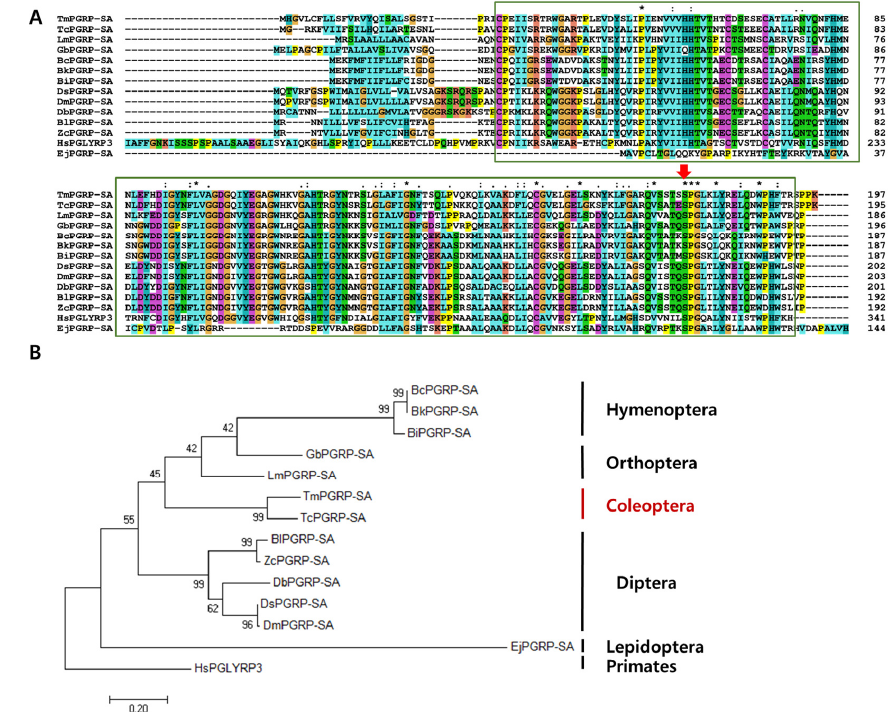
Figure 2. Phylogenetic analyses and alignment of Tm PGRP-SA amino acid sequence with those from other species. The amidase / PGRP domain is marked in green boxes. Asterisk, colon, and period symbols indicate conservation scores between the sequences of representative PGRP-SA proteins according to the Gonnet PAM 250 matrix (‘*’ > ‘:’ > ‘.’) and ‘-’ indicates internal or terminal gaps. The Red Green Blue (RGB) colors are identified based on RGB values (from 0 to 255). Red color shows 229, 51, and 25 RGB values, blue (25, 127, and 229), green (25, 204, and 25), cyan (25, 178, and 178), pink (299, 127, and 127), magenta (204, 76, and 204), yellow (204, 204, and 0), and orange (229, 153, and 76) ( A ). Red arrow indicates the conserved serine amino acids. Phylogenetic tree constructed using maximum likelihood (ML) method based on the Jones-Taylor-Thornton (JTT) matrix model in MEGA 7.0 (1000 bootstrap replicates). The MT tree were rooted with the protein sequences of Tm PGRP-SA ( Tenebrio molitor peptidoglycan recognition protein SA), Tc PGRP-2 ( T. castaneum REDICTED: peptidoglycan recognition protein 2; P_008192927.1), Lm PGRP-SA ( Locusta migratoria peptidoglycan recognition protein SA; AFD54029.1), Bc PGRP-SA ( Bombus consobrinus peptidoglycan recognition protein SA; ATL64828.1), Bk PGRP-SA ( Bombus koreanus peptidoglycan recognition protein SA; ATL64813.1), Gb PGRP-SA ( Gryllus bimaculatus peptidoglycan recognition protein SA; BBG28438.1), Ds PGRP-SA ( Drosophila